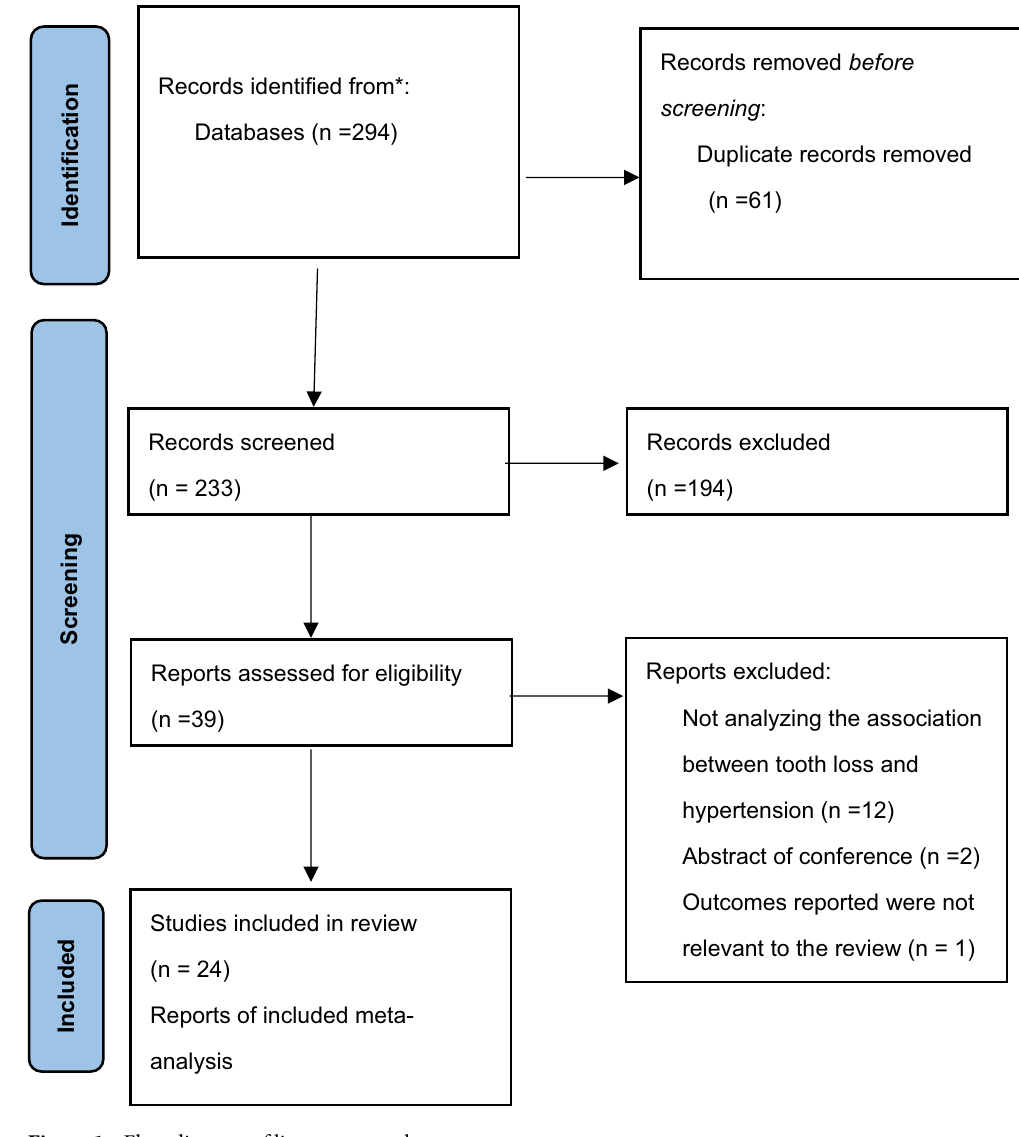
Figure 1. Flow diagram of literature